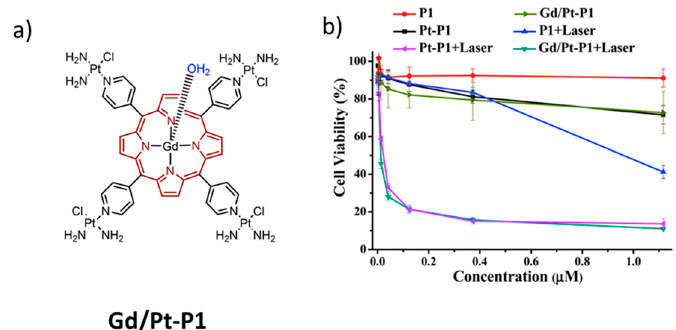
Figure 4. ( a ) Molecular representation of Gd/Pt-P1; ( b ) C6 cell viability as a function of three porphyrin (P1, Pt-P1, and Gd/Pt-P1) concentrations without irradiation (6 h incubation) and 44 h after irradiation at 630 nm (0.2 W/cm, 10 min). Adapted from [49] with permission from the Royal Society of Chemistry.